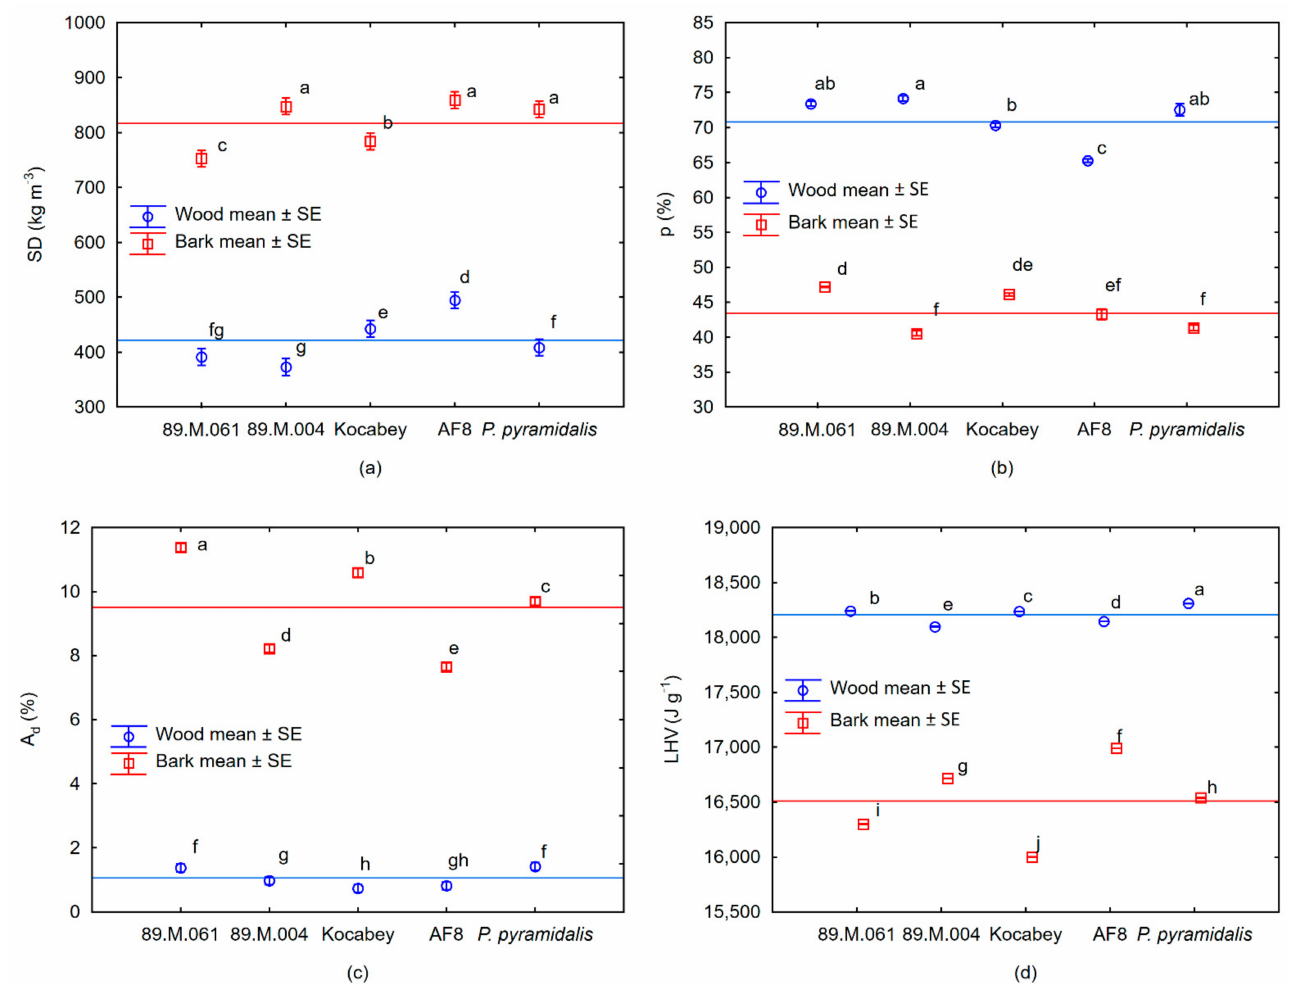
Figure 3. Mean values ± standard error (vertical bar) of wood and bark for: ( a ) specific density (SD (kg m –3 )), ( b ) porosity (p (%)), ( c ) ash content (A d (%)), ( d ) low heating value (LHV (J g − 1 )). The same letters indicate statistically homogenous groups of clones at p < 0.05 in the LSD